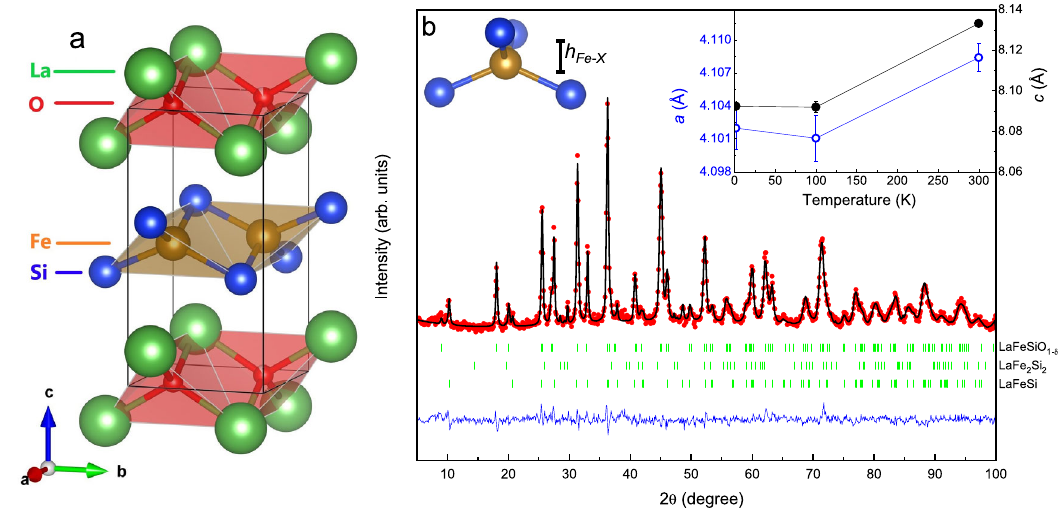
Fig. 2 Crystallographic structure from NPD. a The crystal structure as determined by NPD. The structure is shifted by (0,0,0.5) to emphasize the Fe-containing layer. b Rietveld re fi nement of the NPD data collected at 300 K at the D1B instrument of ILL. Three phases are included: LaFeSiO 1 − δ , LaFe 2 Si 2 and unreacted LaFeSi (from top to bottom). Inset: Temperature dependence of a and c lattice parameters. Errors are based on the errors obtained from the Rietveld fi